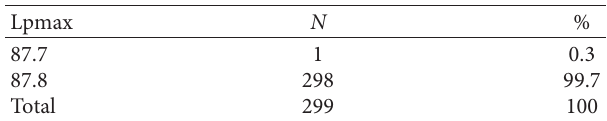
Figure 5: Sound level Lp in the center of the practical classroom. Table 4: Maximum sound level Lpmax in the center of the practical